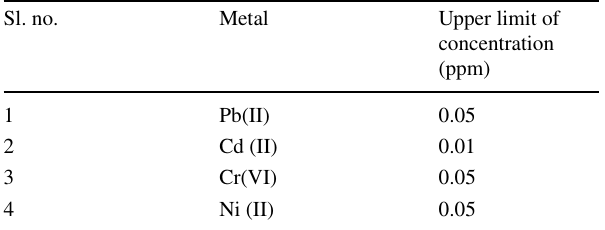
Table 1 Maximum limits of heavy metals suggested by the World health organization (WHO) Sl.